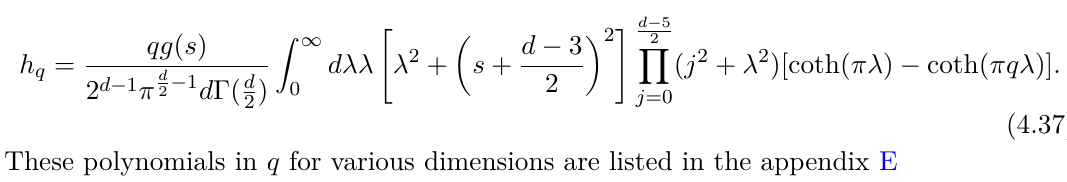
Table 2 . Entanglement entropies of spin- s fields in D